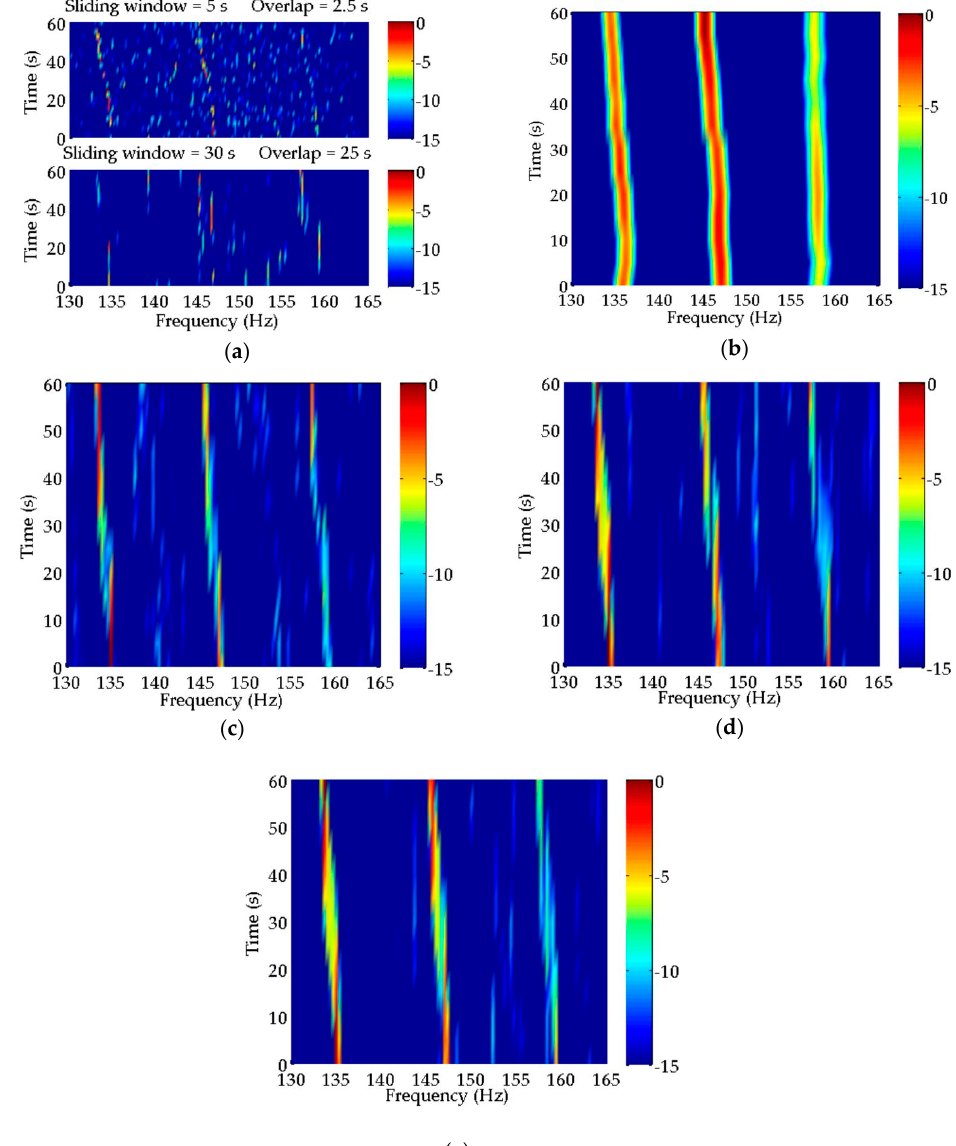
Figure 5. Estimation results of discrete spectra in simulated signals with SNR = 20 dB obtained by ( a ) compressed sensing (CS); ( b ) Multiple Signal Classification (MUSIC); ( c ) Cross ‐ Power Spectrum Coherent Integration (CPSCI); ( d ) Cross ‐ Power Spectrum Incoherent Integration (CPSII) and ( e ) Compensated Cross ‐ Power Spectrum Coherent Integration (CCPSCI). ( a ) In the top subfigure, CS can